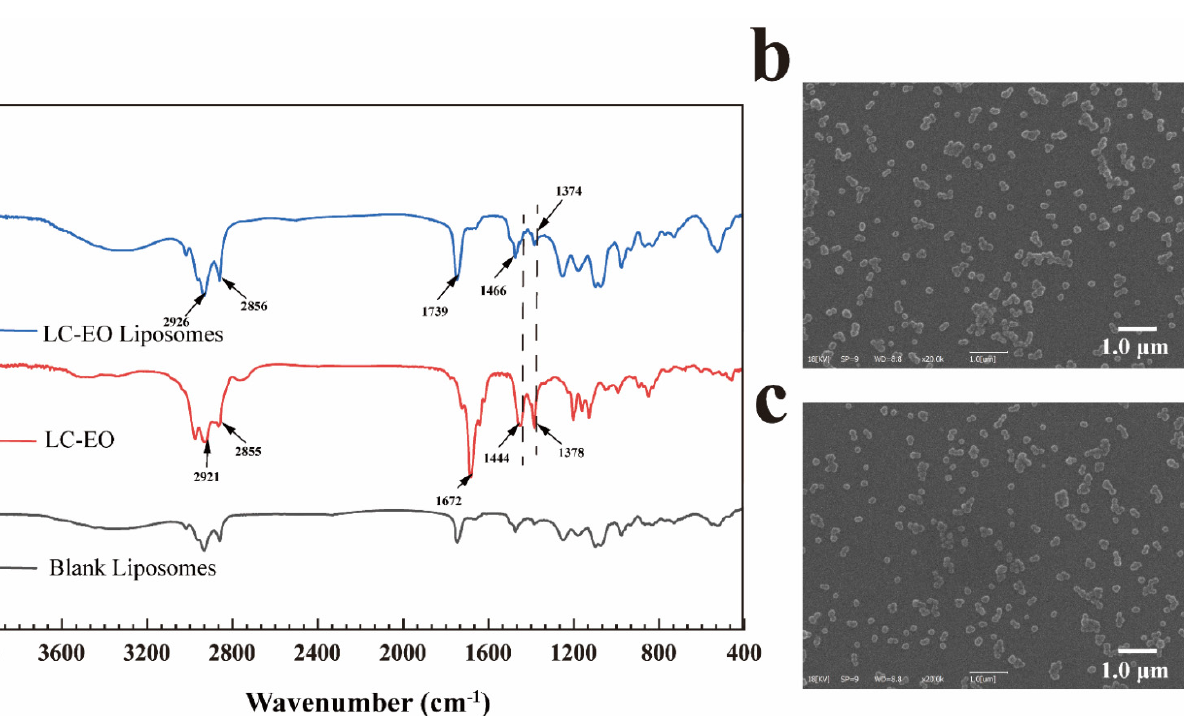
Figure 2. FTIR spectra of blank liposomes, LC-EO, and LC-EO liposomes ( a ). SEM images of blank liposomes ( b ) and LC-EO liposomes ( c ). Scale bar: 1.0 μ m.